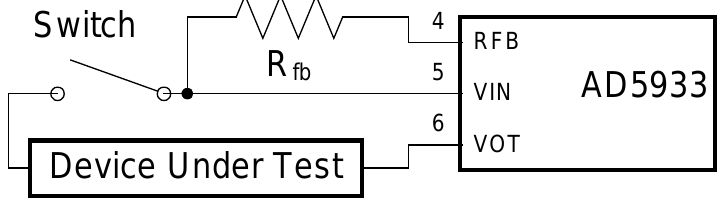
Figure 7. Simplified schematic for eliminating AD5933 internal DC leakage from network analysis: internal DC offset is processed by the on-chip circuitry and recorded when the switch is